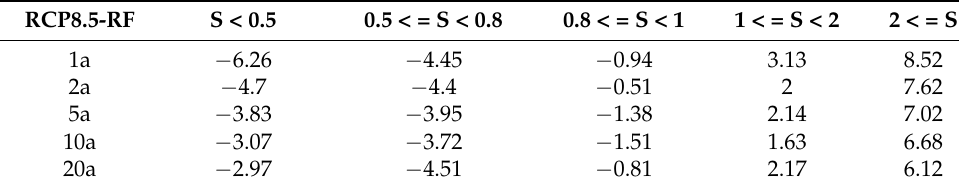
Table 12. Conduit surcharge performance RCP8.5 relative RF (unit: %).